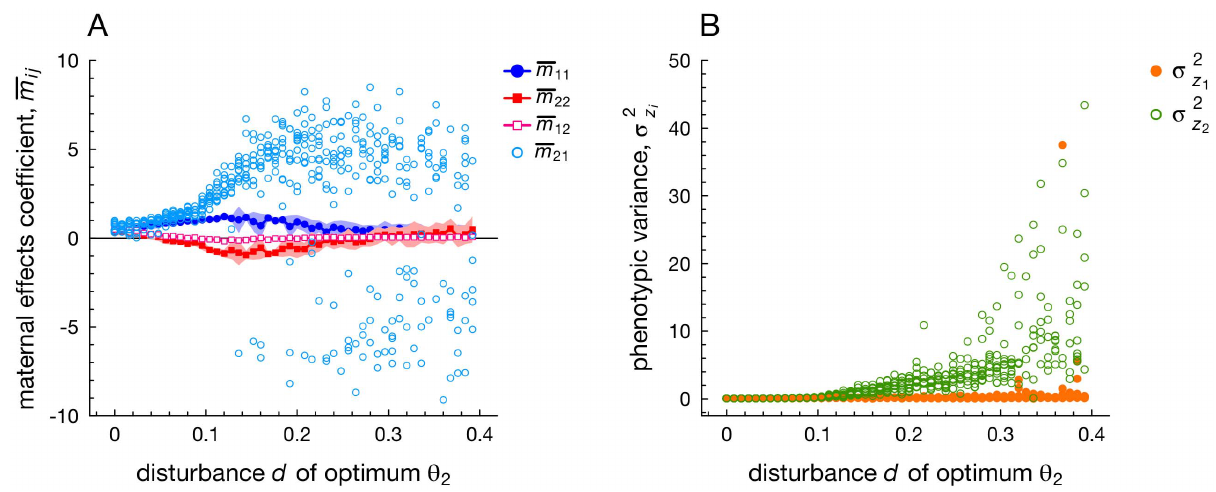
Figure 5. The evolution of multivariate maternal effects when varying the degree of noise in selective optimum h 2 while selective optimum h 1 remains noise-free. Panel A: evolving maternal effects. Panel B: corresponding phenotypic variances s 2 showing that phenotype z 2 exhibits increased phenotypic variance (resulting in bet-hedging) when compared to z 1 .